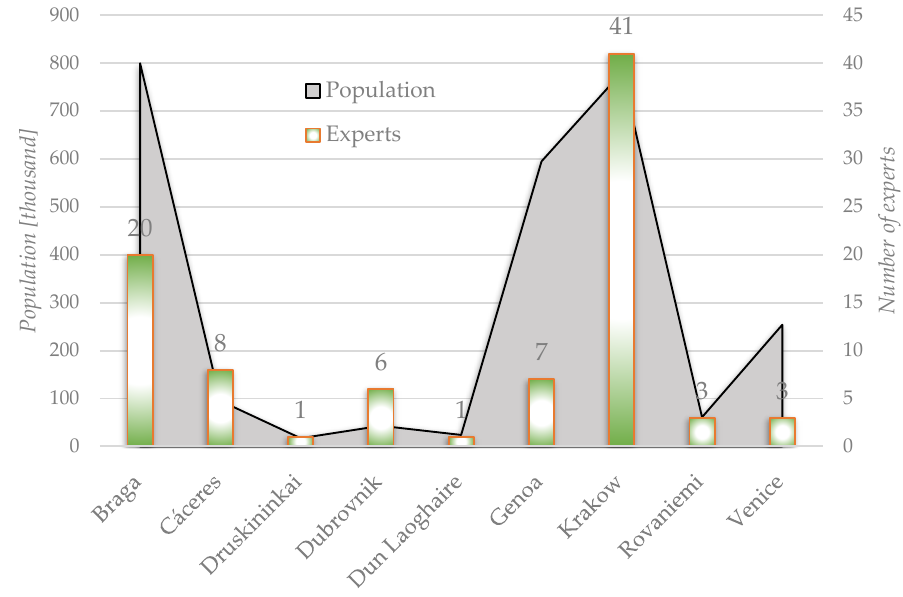
Figure 2. Distribution of the TFC population and the number of experts. Source: Own study. Interviews were conducted using an online questionnaire in the last quarter of 2021.